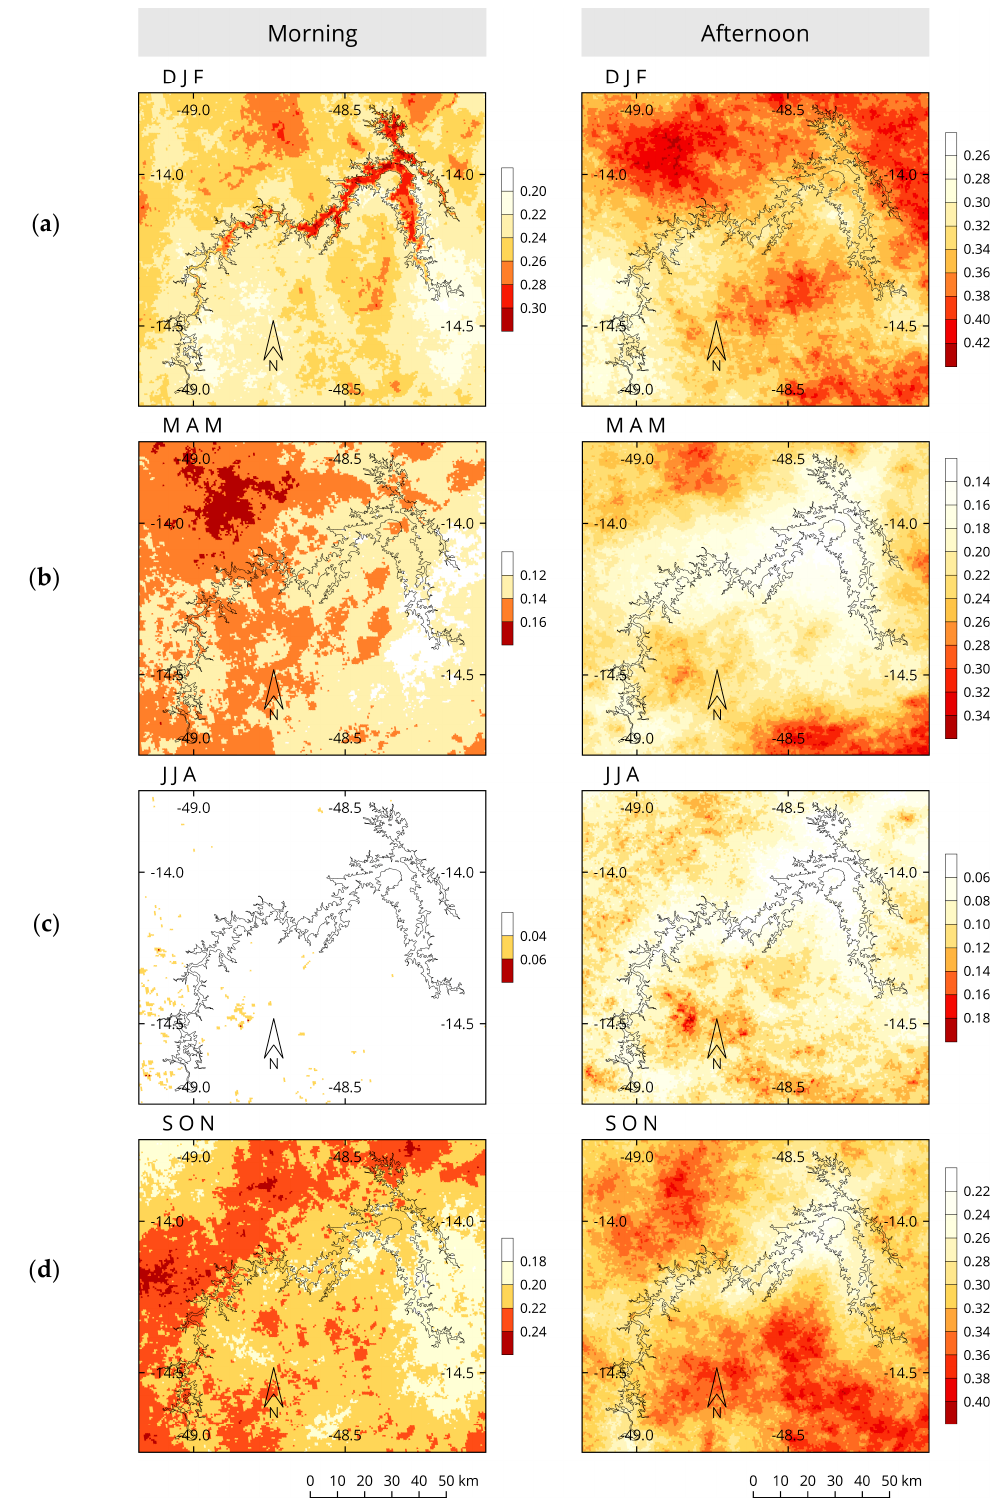
Figure 7. Seasonal maps of average (cid:1829) (cid:3032)(cid:3033)(cid:3033) estimates (%) over the Serra da Mesa Reservoir for the morning (9–11h LT) and afternoon (14–16h LT) periods for ( a ) December, January, February (DJF); ( b ) March, April, May (MAM); ( c ) June, July, August (JJA); and ( d ) September, October, November (SON).